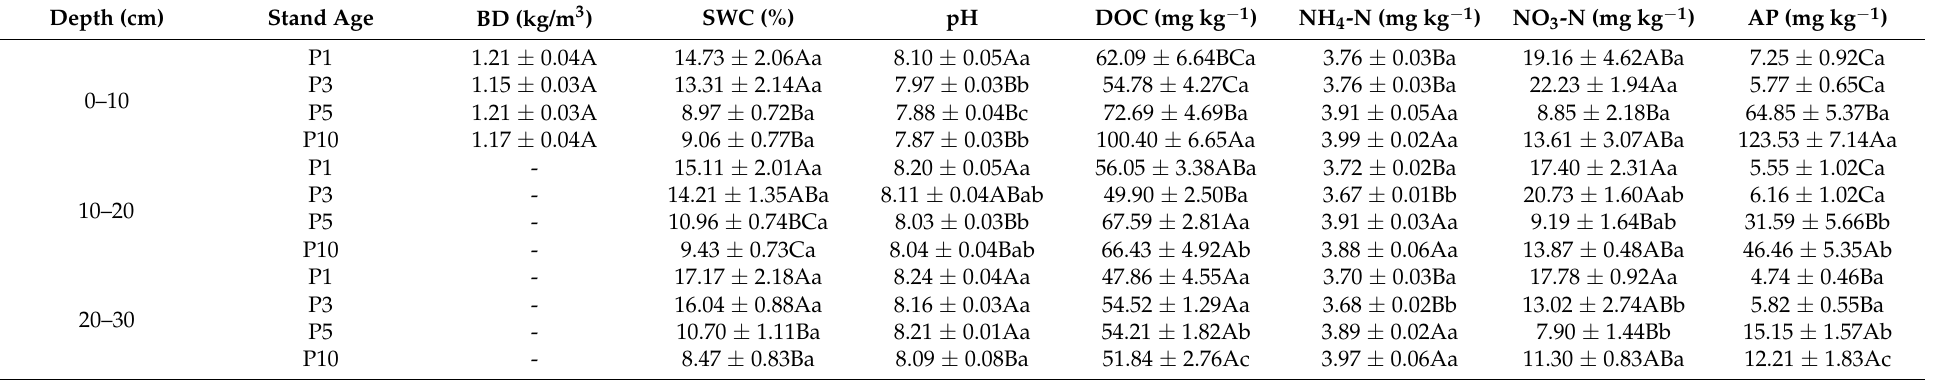
Table 3. Changes of soil BD, SWC, pH, DOC, NH 4 -N, NO 3 -N, and AP in different soil depths along an age sequence of pomegranate plantation